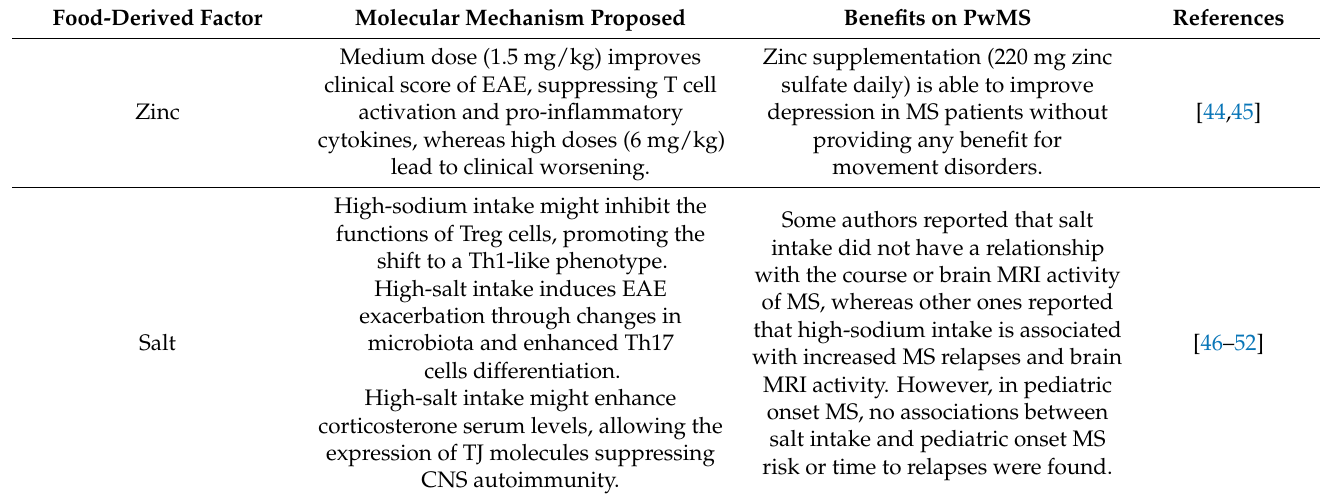
Table 3. Molecular mechanism and possible advantages on pwMS of food-derived